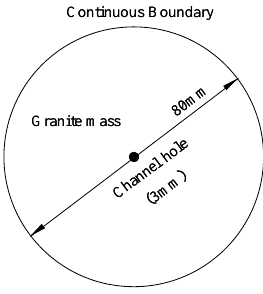
Figure 6. Surface damage model of EPB in granite.